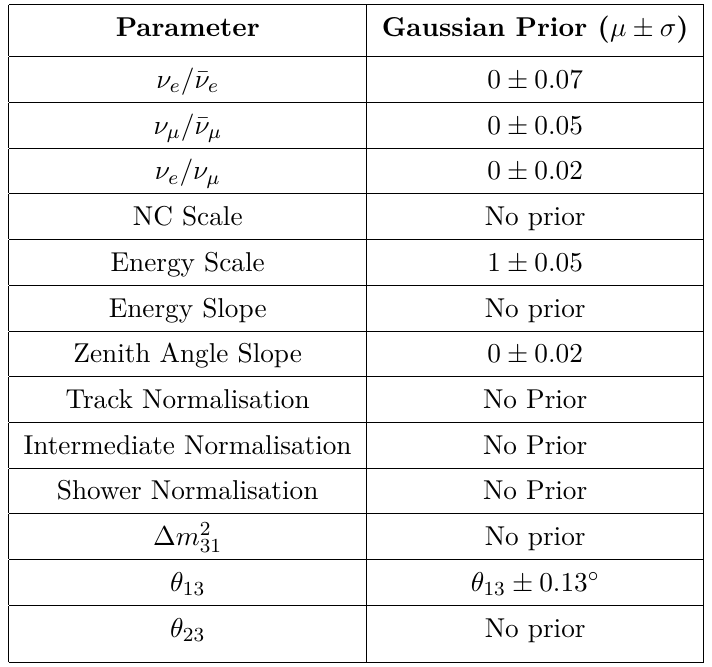
Table 3 . List of fitted values and relative gaussian priors considered in this analysis. θ 13 refers to the values listed in table